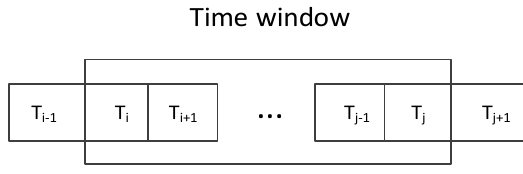
Figure 3. Detection Based on Sliding Time Window.